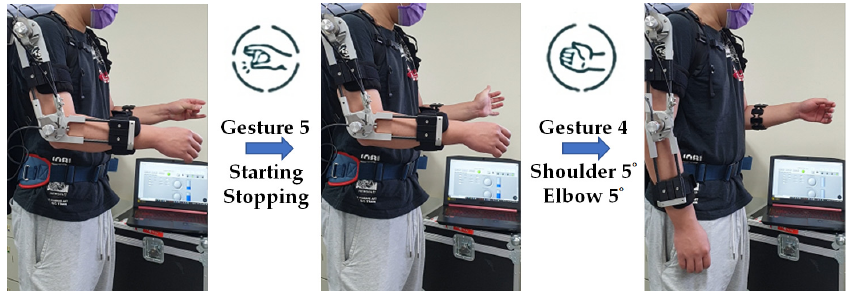
Figure 34. Desired action experiment with a shoulder flexion angle of 5° and an elbow flexion angle of 5°.